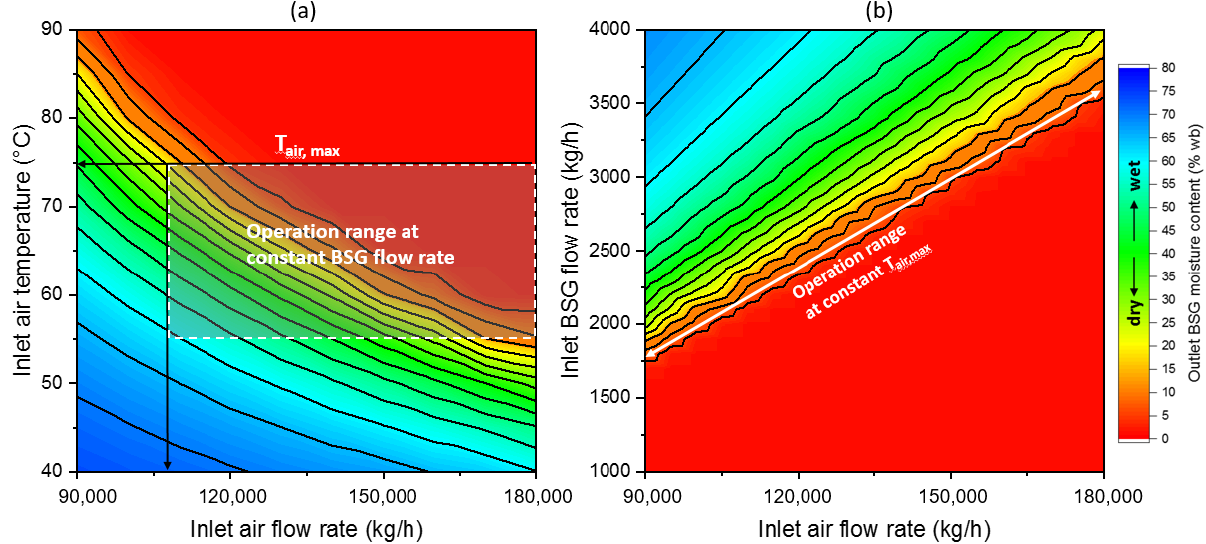
Figure 3. Effect of inlet air flow rate on the outlet moisture of the BSG for ( a ) constant inlet BSG flow rate and ( b ) constant inlet air temperature. Data points presented can be found in the Supplementary Information (Table S1 and Table S2).